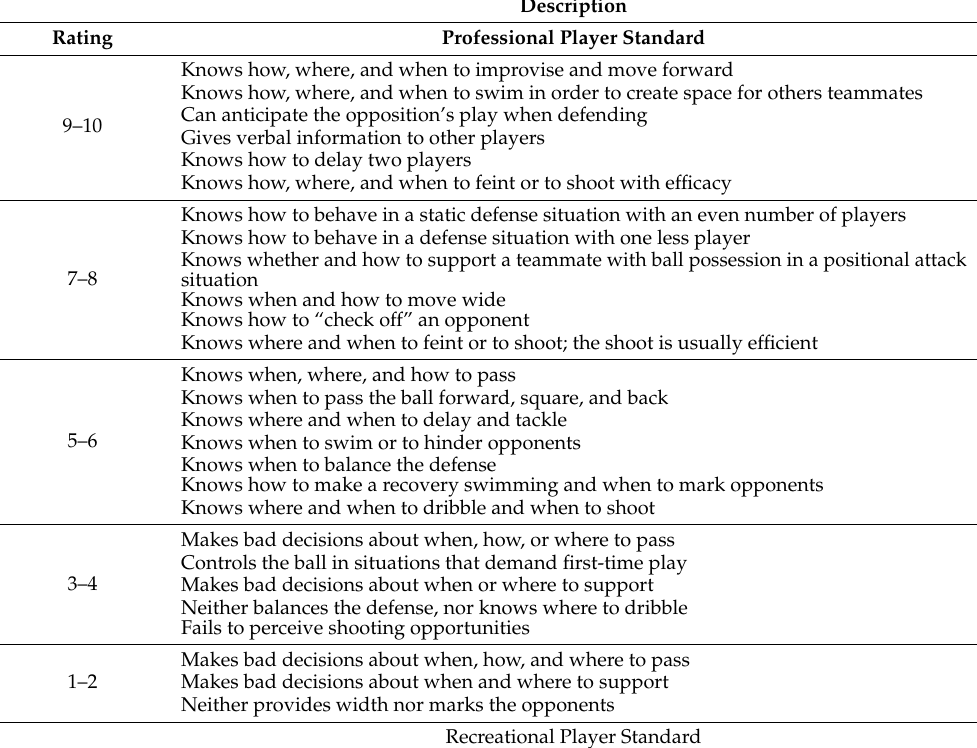
Table 1. Guidelines to the coaches’ evaluation of the players’ decision-making